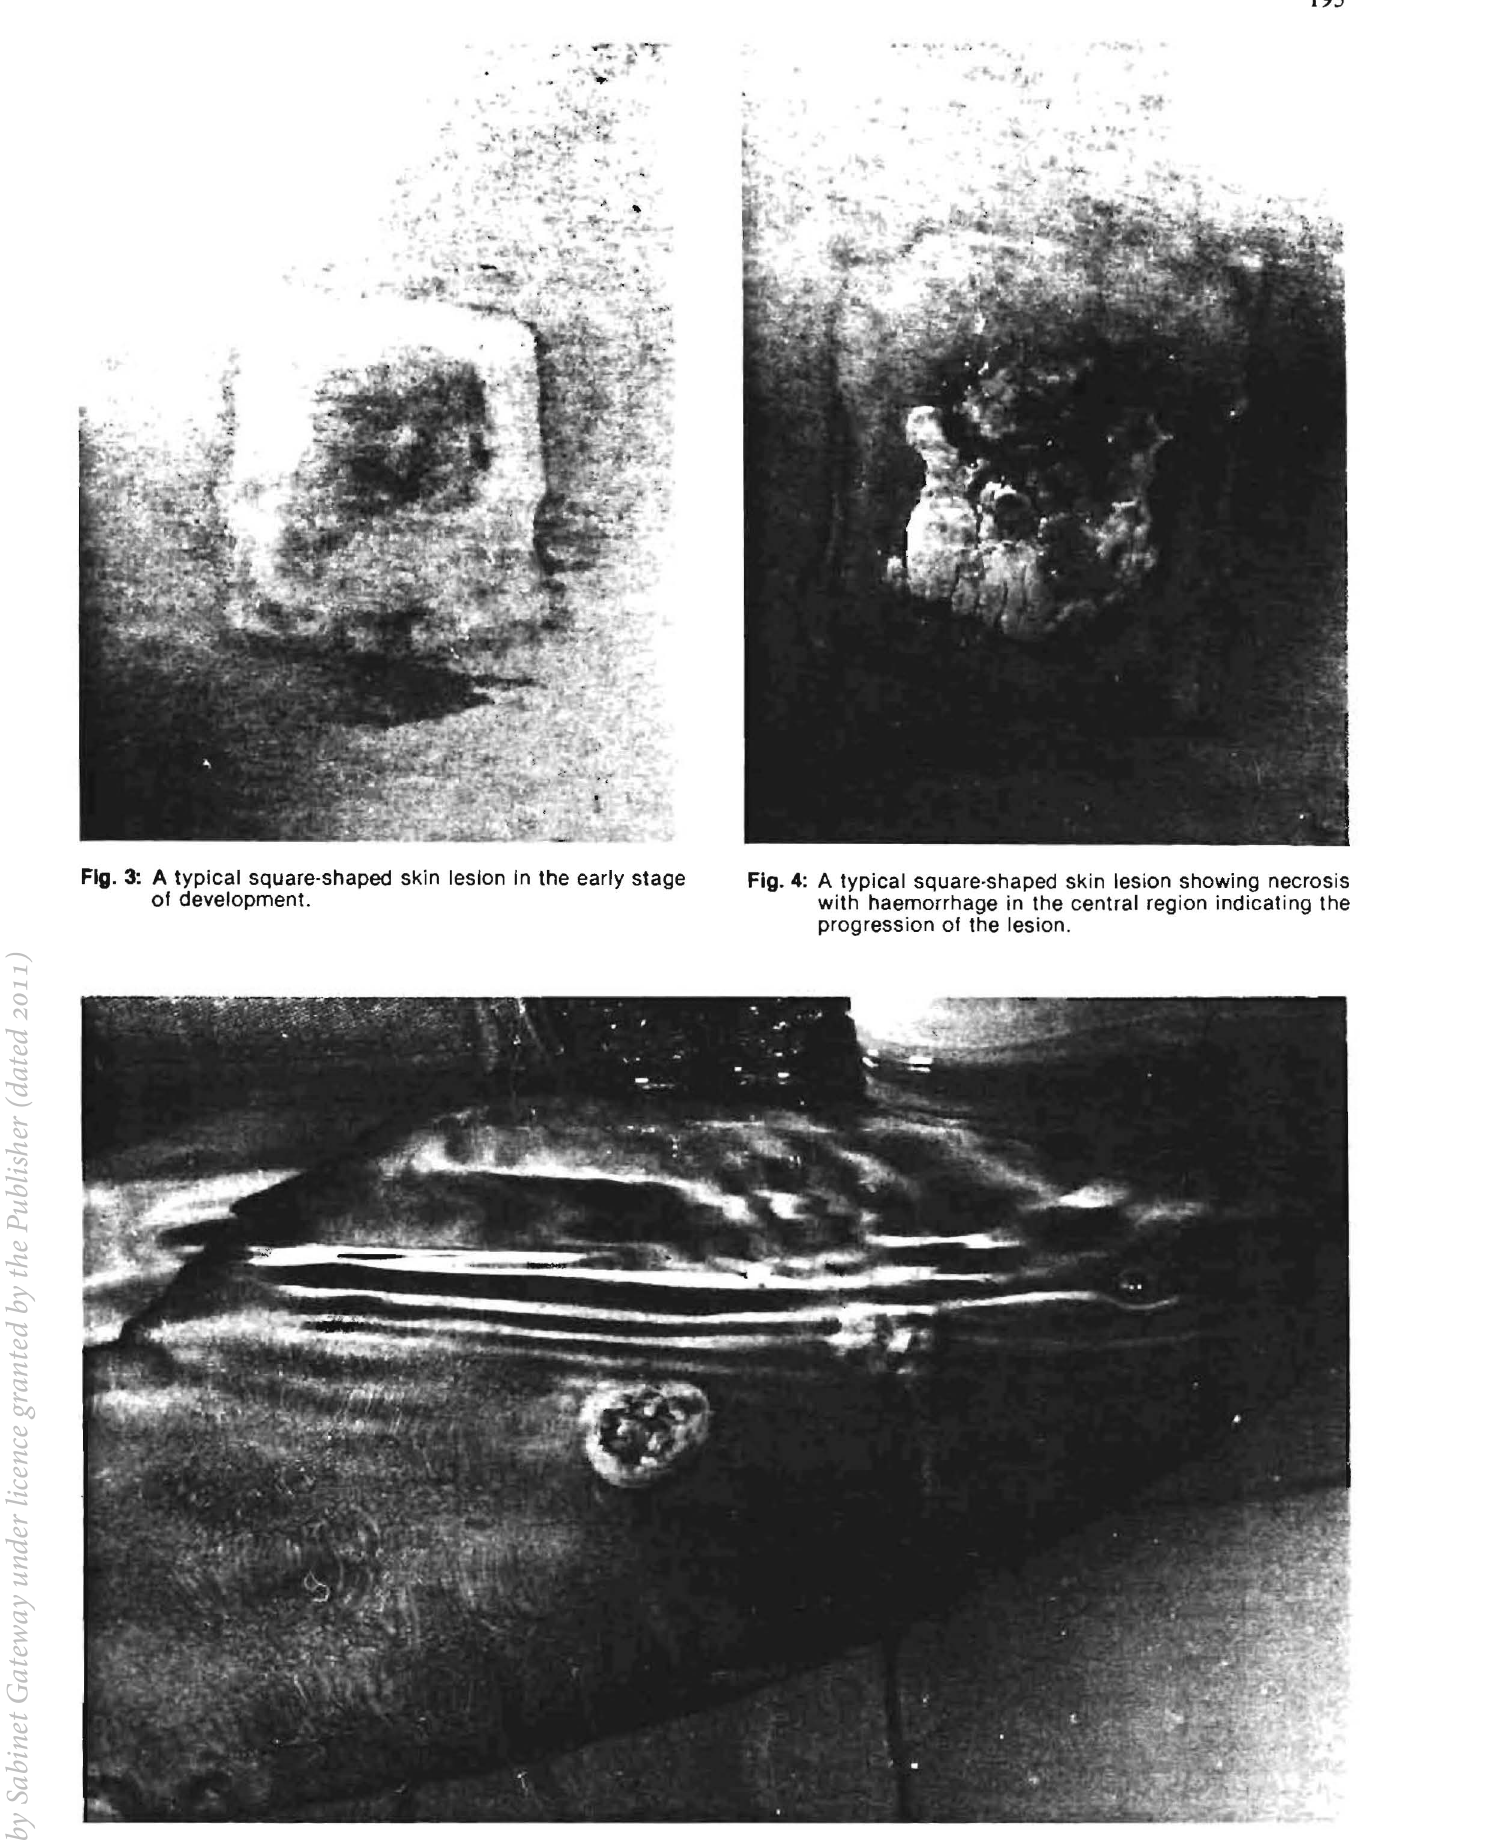
Fig. 5: Atypical round necrotic lesions Observed on the pectoral flippers (as above) and dorsal fin. These lesions eroded, resulting in permanent scarring. JOURNAL OF THE SOUTH AFRICAN VETERINARY ASSOCIA nON - SEPTEMBER